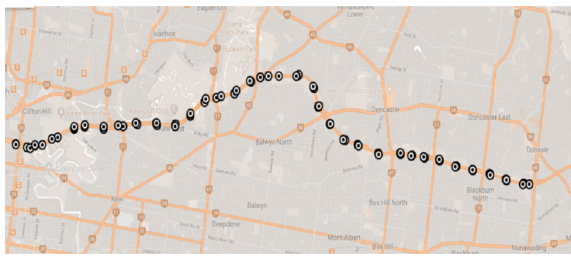
Figure 1. Detections location on the mainstream of Eastern